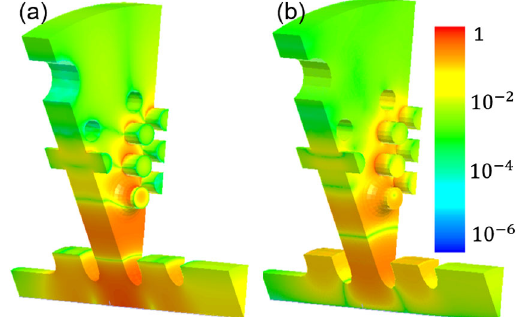
FIG. 10. The normalized field distribution (in log scale) of (a) the surface electric field, and (b) the surface magnetic field of the HPBG-d3 structure in simulation.